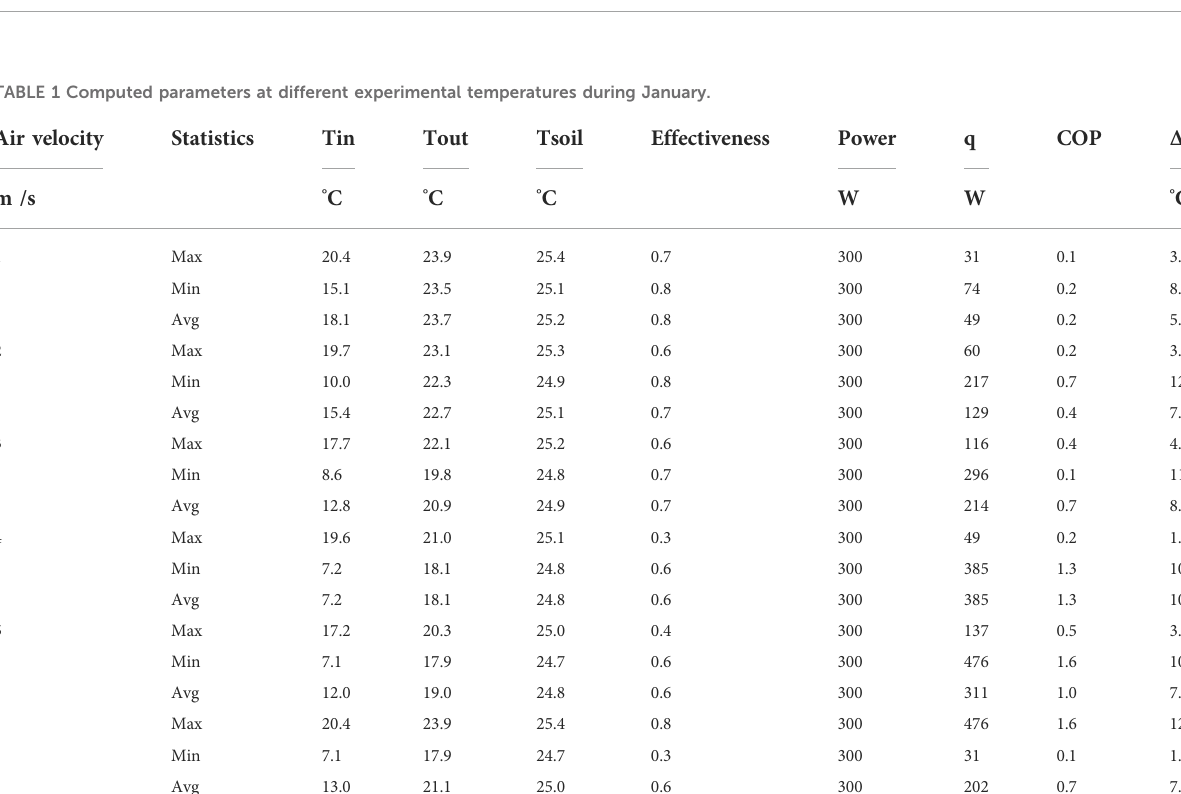
FIGURE 13 Variation of effectiveness with air velocity during (A) January and (B) June.